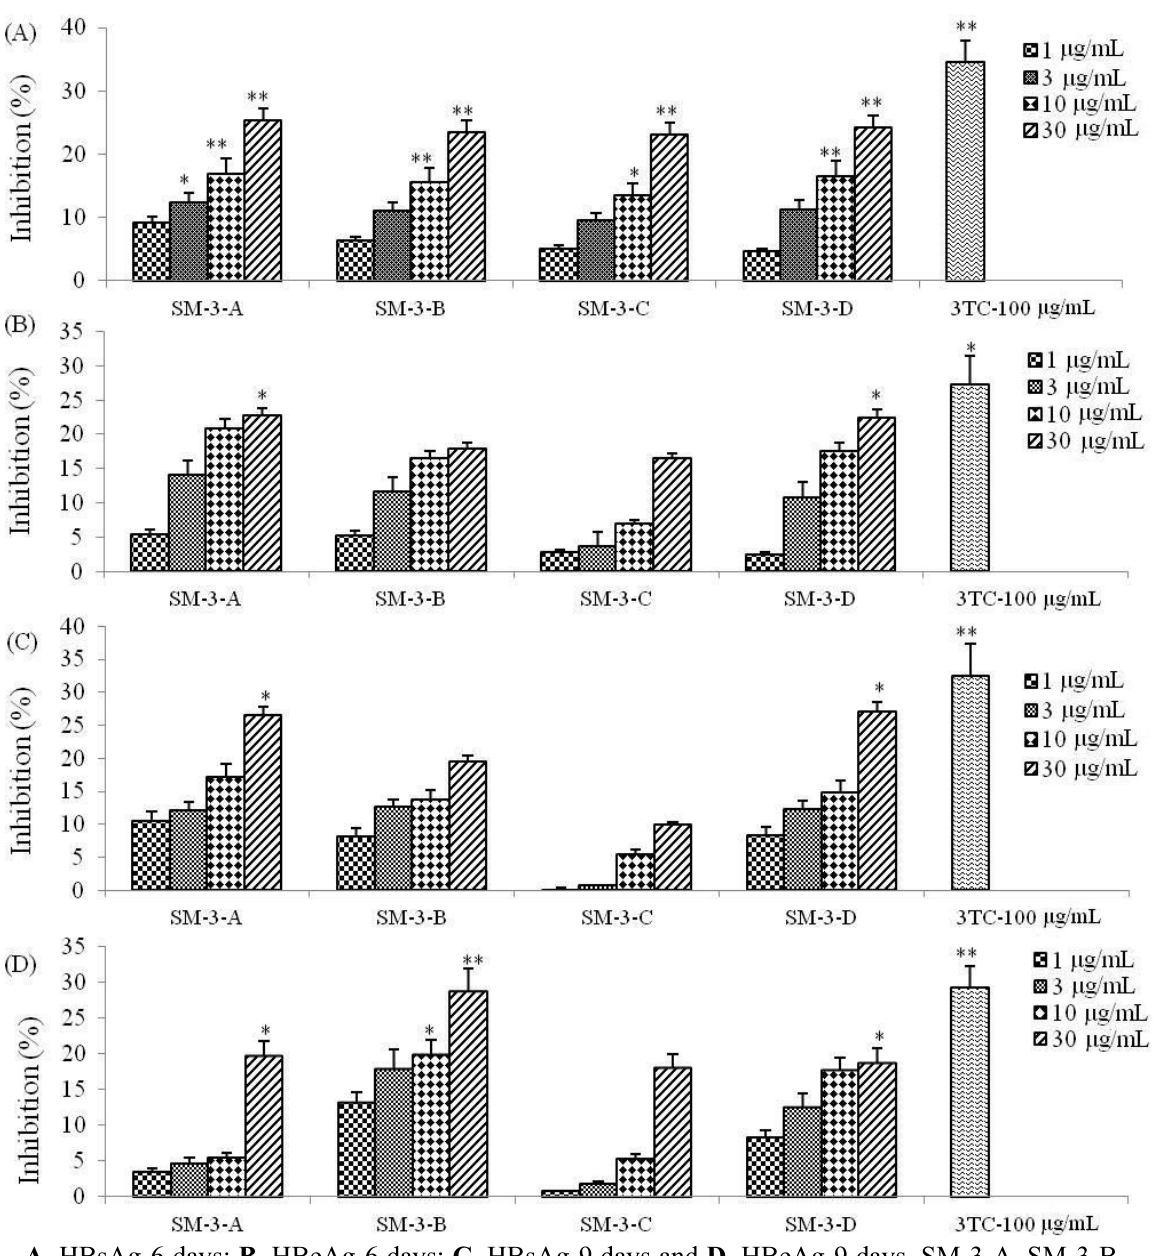
Figure 8. Inhibition of HBsAg and HBeAg secretion by SM-3 and